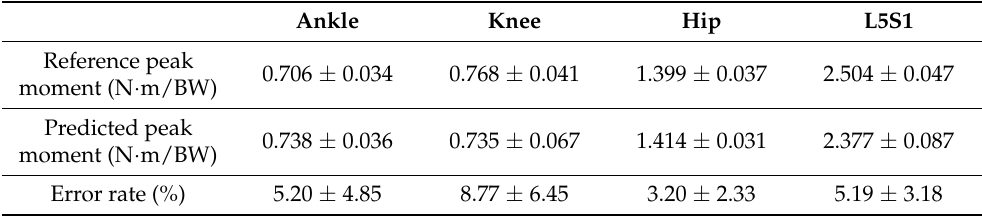
Table 6. Reference peak moment calculated from OTS, peak moment predicted from SVM-LSTM model, and error rate between these